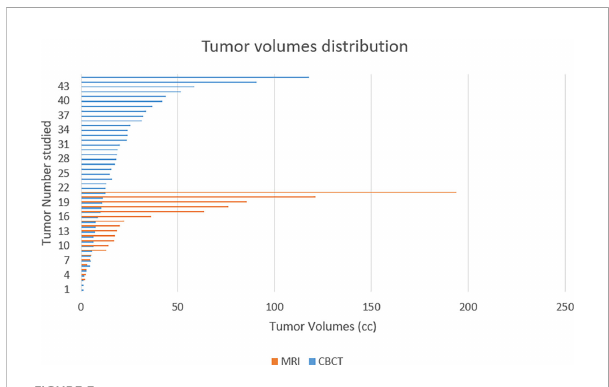
FIGURE 3 Patients treated using a conventional linac (CBCT) had non- signi fi cantly smaller tumor volumes than those treated on the MRIdian system